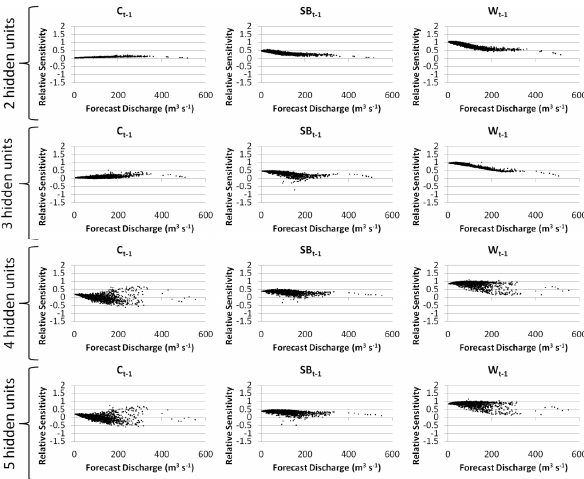
Figure 12. Global-local relative sensitivity plots for all candidate models in Scenario B: calibration data.